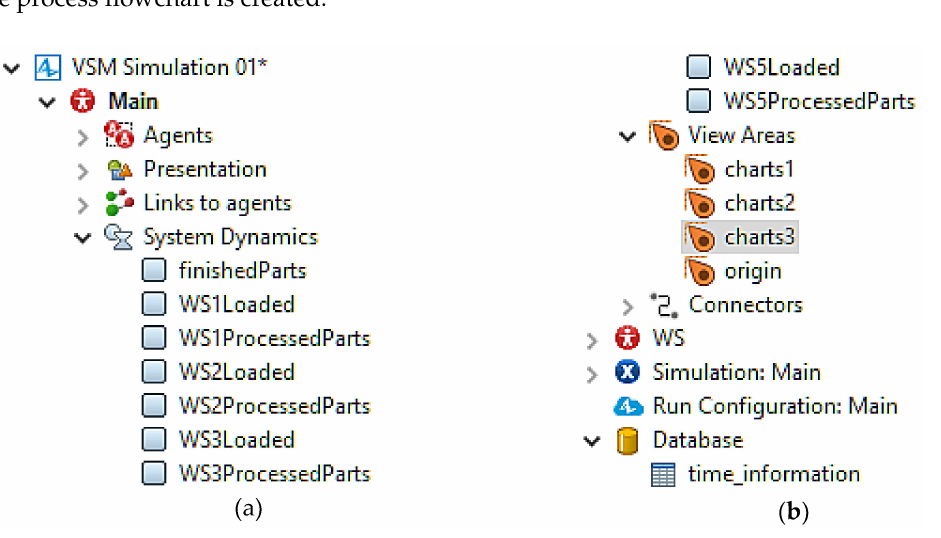
Figure 1. AnyLogic project ( a ) Design of agent; ( b ) Design of view areas.